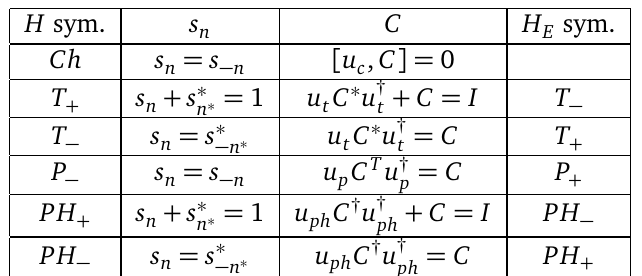
Table 2: Conditions to obtain an alternate symmetry representation in the entan- glement Hamiltonian of the different symmetries of the system Hamiltonian. The original symmetry of the Hamiltonian (first column), under the suitable choice of many-body state (second column) leads to different symmetry properties for the cor- relation matrix (third column), which means that H will have a different symmetry E (last column). Two special cases emerge. The chiral symmetry leads to the appear- ance of a new conserved quantity, corresponding to the chiral operator u . The P + c symmetry does not appear in this table. Under the assumption that there are no de- generacies in H , the entanglement Hamiltonian is also always P + symmetric. It is interesting to note that the P − symmetry then leads to a doubly degenerate entangle- ment Hamiltonian. Except from Ch and P − , these symmetry conditions are natural in the anti-Hermitian